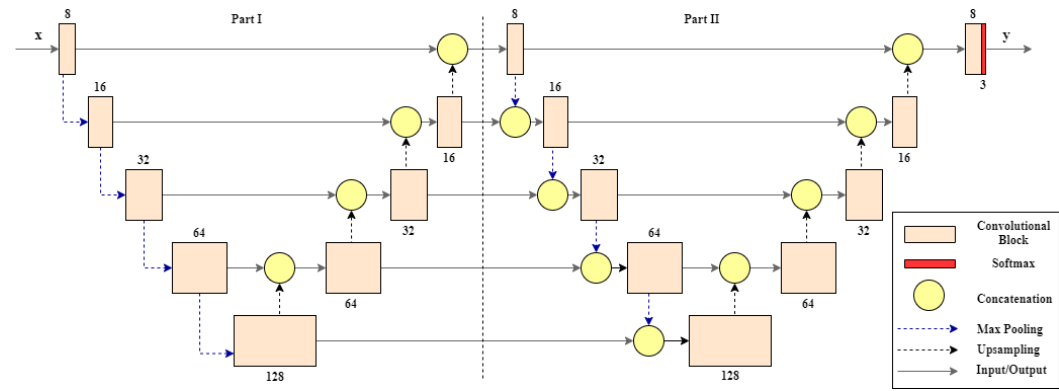
Figure 5. The proposed W-Net